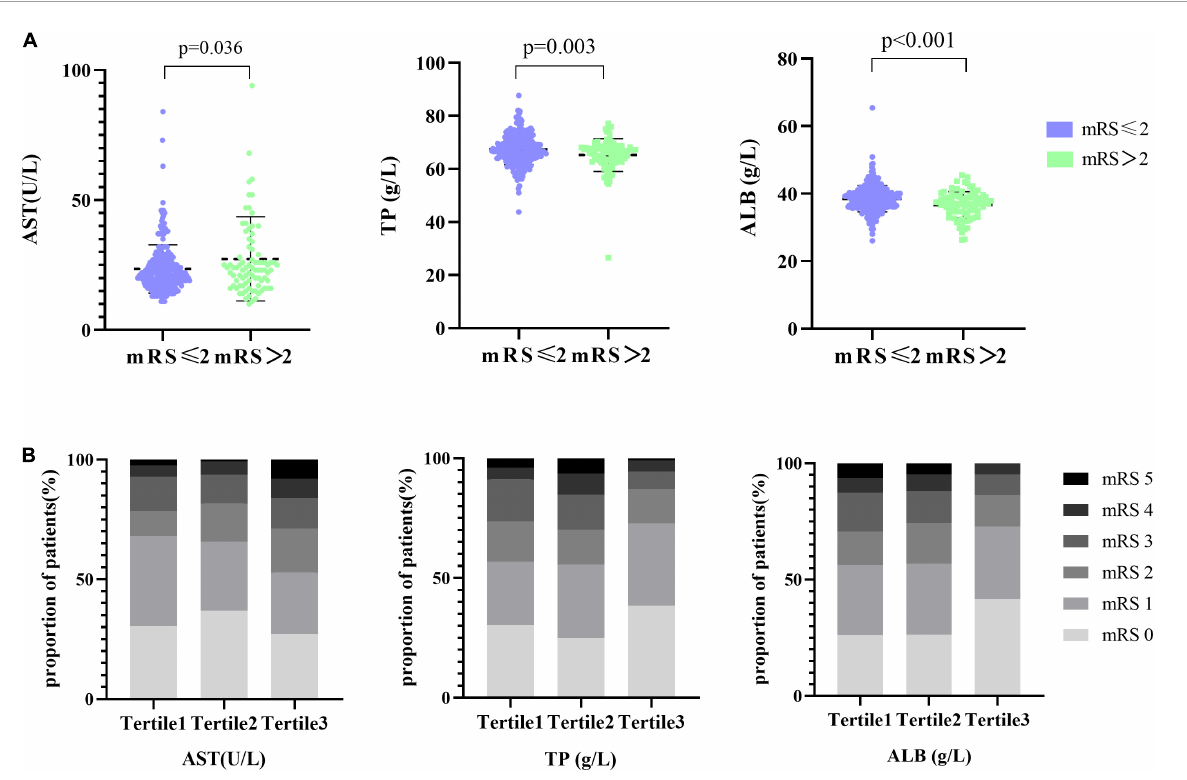
FIGURE1 Distribution of AST and TP with the different mRS groups. (A) The scatter diagram in the distribution of AST, TP, and ALB between the mRS ≤ 2 and mRS > 2 groups, respectively. (B) Functional outcome at 1 year based on the mRS, presented as percentage and stratified by AST, TP, and ALB levels. Patients were divided into the three groups according to the tertiles of AST (AST ≤ 19 U/l, 19 U/l < AST ≤ 25 U/l, AST > 25 U/l), the tertiles of TP (TP ≤ 64.9 g/l, 64.9 g/l < TP ≤ 68.7 g/l, TP > 68.7 g/l), and the tertiles of ALB (ALB ≤ 36.7 g/l, 36.7 g/l < ALB ≤ 39.4 g/l, ALB > 39.4